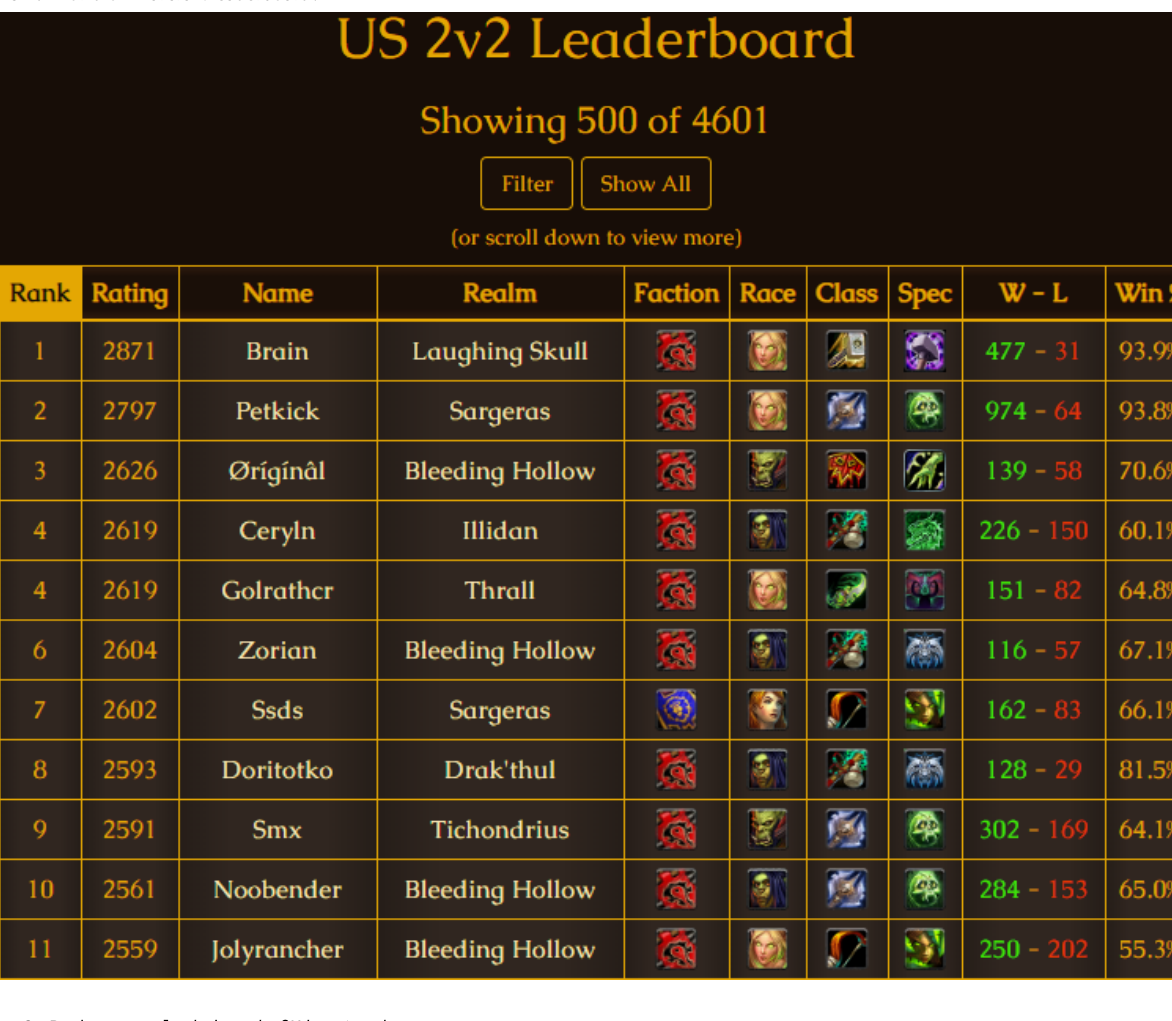
Figure 3. Badge count leaderboard of Khan